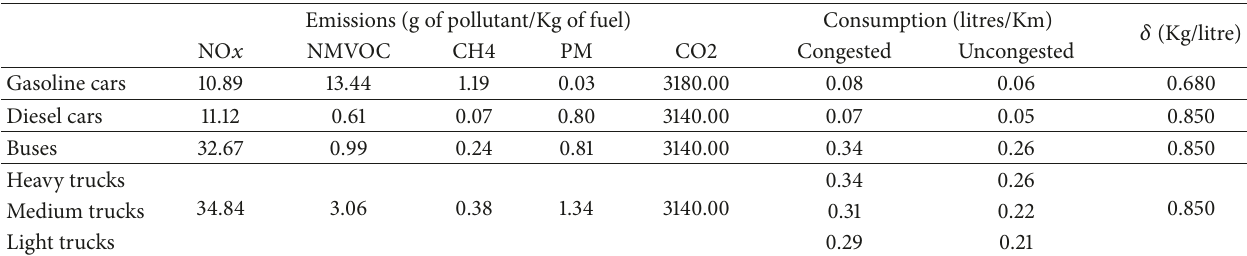
Table 2: Environmental cost of each kind of pollutant (€/ton) [28]. NO 𝑥 NMVOC CH4 PM CO2 €/ton of pollutant 3.60